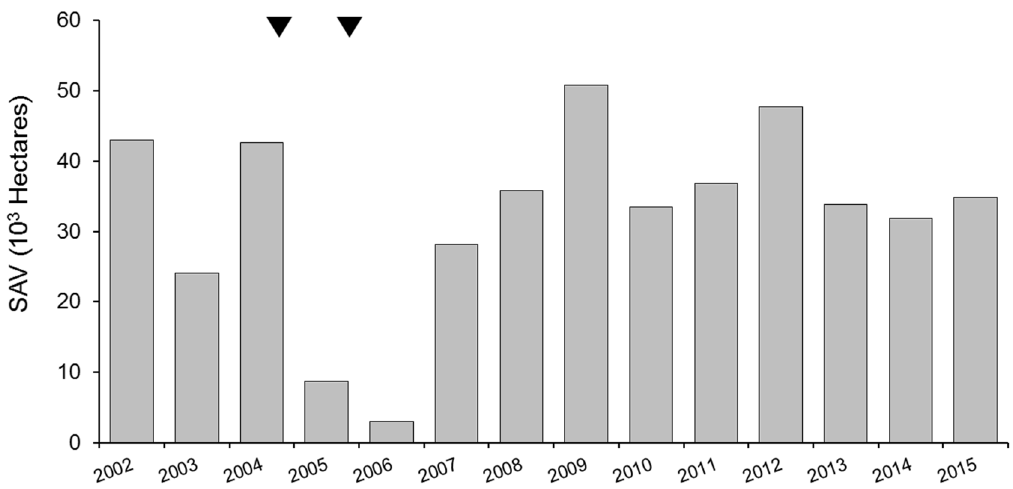
Figure 5. Time series of yearly estimates of the spatial extent of SAV in Lake Okeechobee in the context of three hurricanes that impacted the lake in 2004 and 2005.